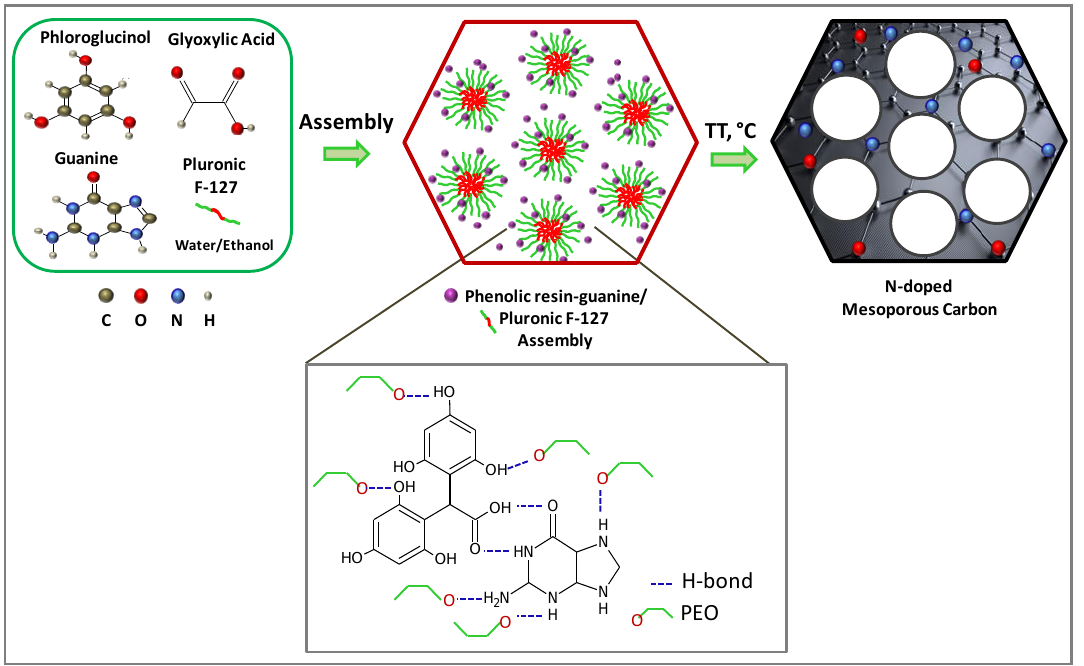
Figure 1. Schematic representation of the synthesis process of N-doped mesoporous carbon and the involved mechanism.